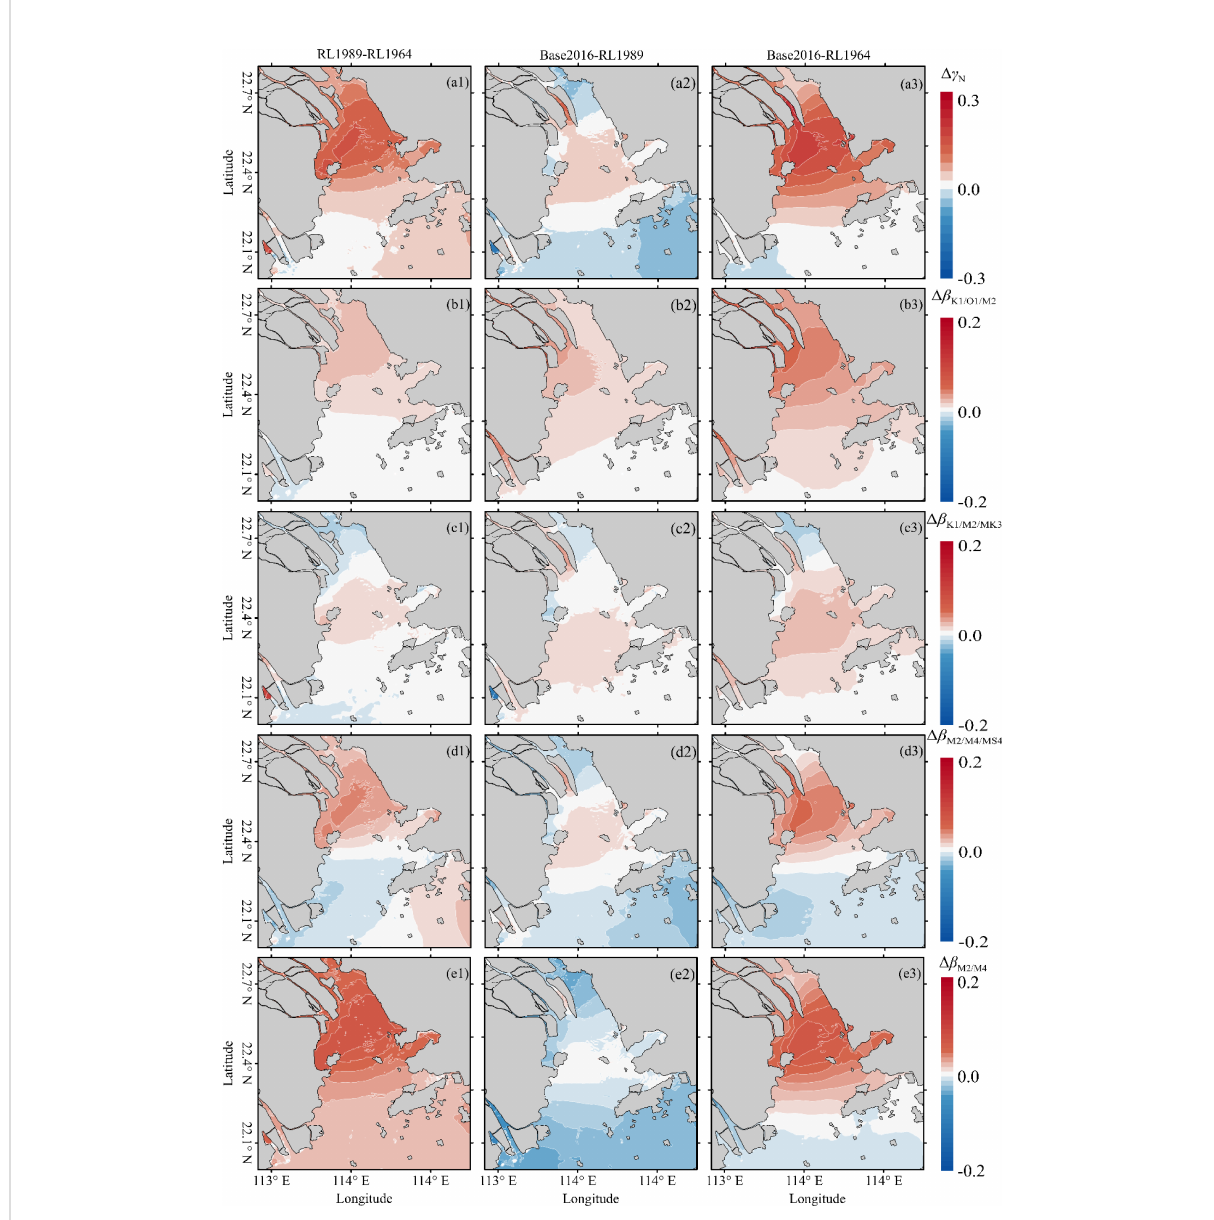
FIGURE 8 Contour map of the variations of the tidal skewness and its primary contributors caused by shoreline changes, including b K 1/ O 1/ M 2 (B1 – B3) , b K 1/ M 2/ MK 3 (C1 – C3) , b M 2/ S 2/ MS 4 (D1 – D3) , and b M 2/ M 4 (E1 – E3) . Number 1, 2, 3 represent RL1989-RL1964, Base2016-RL1989, and Base2016-RL1964,